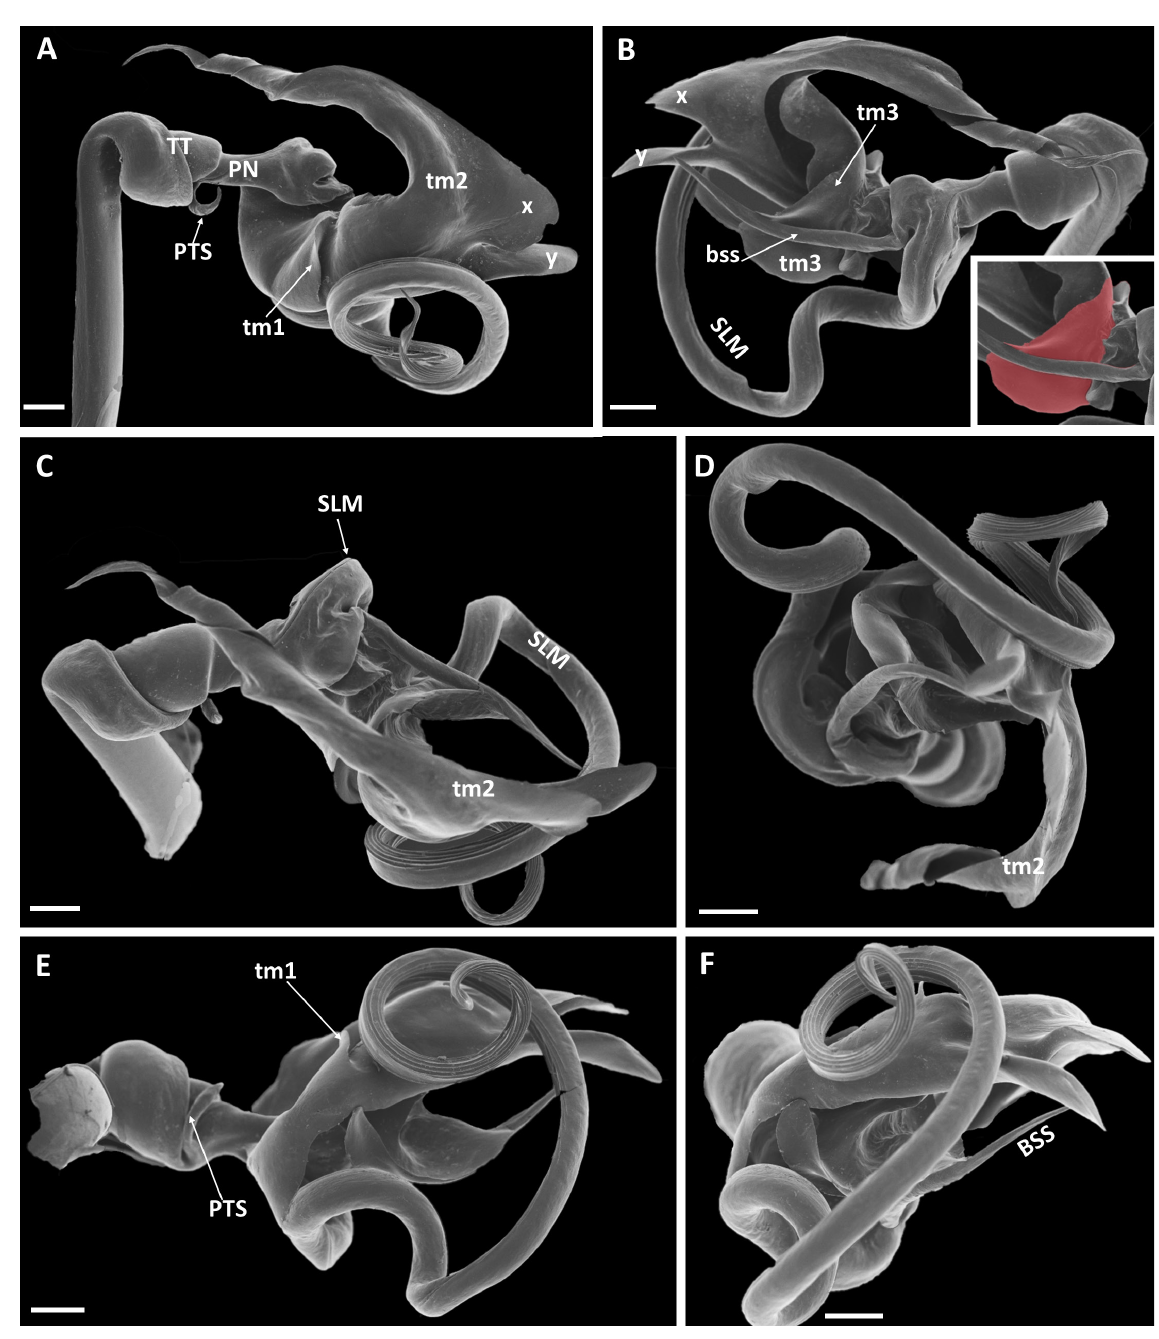
Fig. 33. Chaleponcus sergeii sp. nov., paratype, ♂ (NHMD 621731), left gonopod telopodite. A . Anterior view. B . Posterior view, inset: tm3 highlighted. C . Ventral view. D . Dorsal view. E–F . Dorso-mesal views. Abbreviations: BSS = proximal solenomeral spine; PN = post-torsal narrowing; PTS = post-torsal spine; SLM = solenomere; tm1 , tm2 , tm3 = telomeral branches of tm ; x , y = mesad lobes of tm2 . Scale bars = 0.2